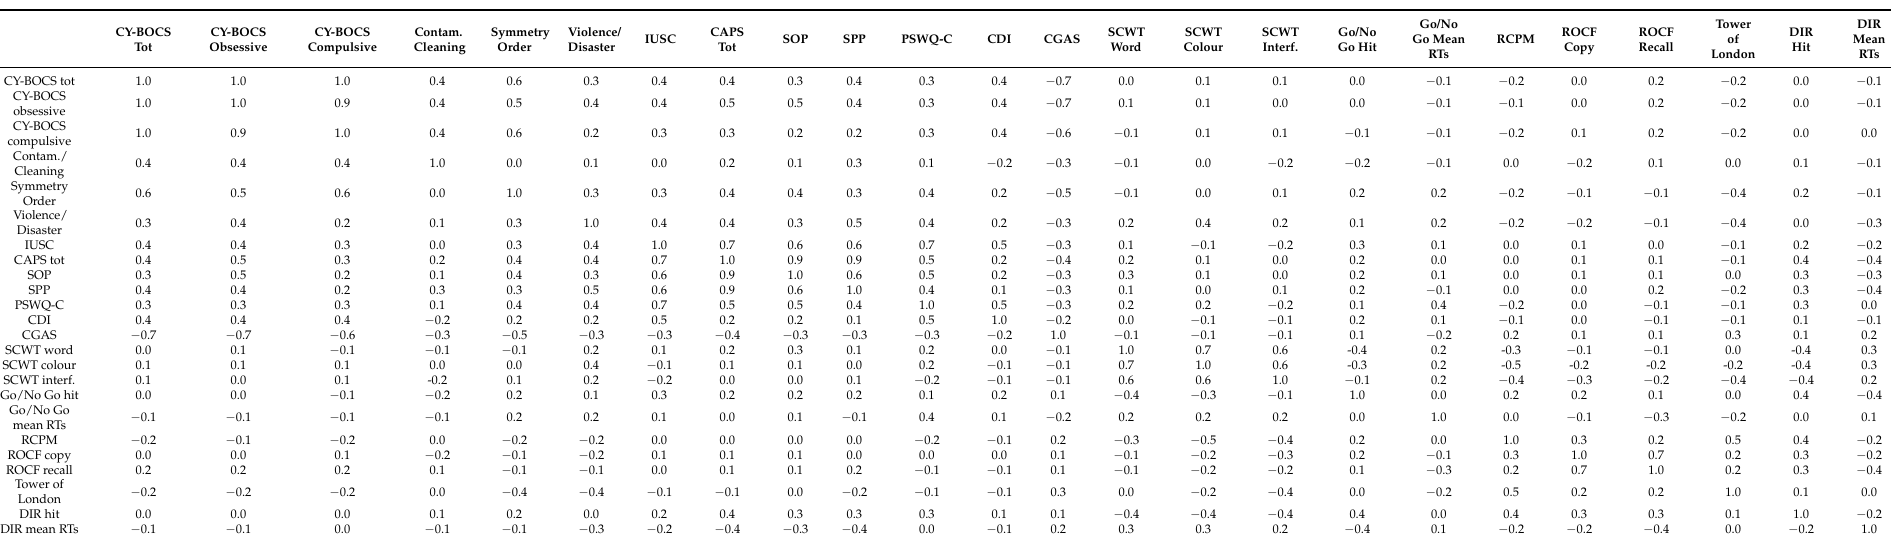
Table 2. Correlation Matrix for clinical and cognitive variables for the whole